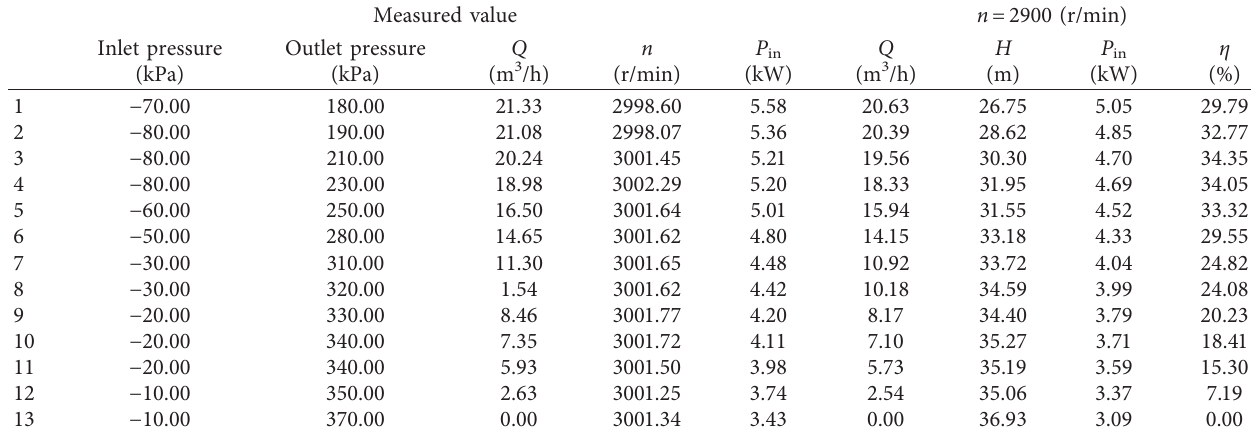
Table 6: Performance experiment of logarithmic spiral